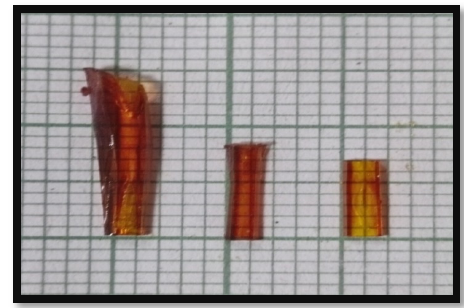
Figure 2. The grown MMPI crystal.